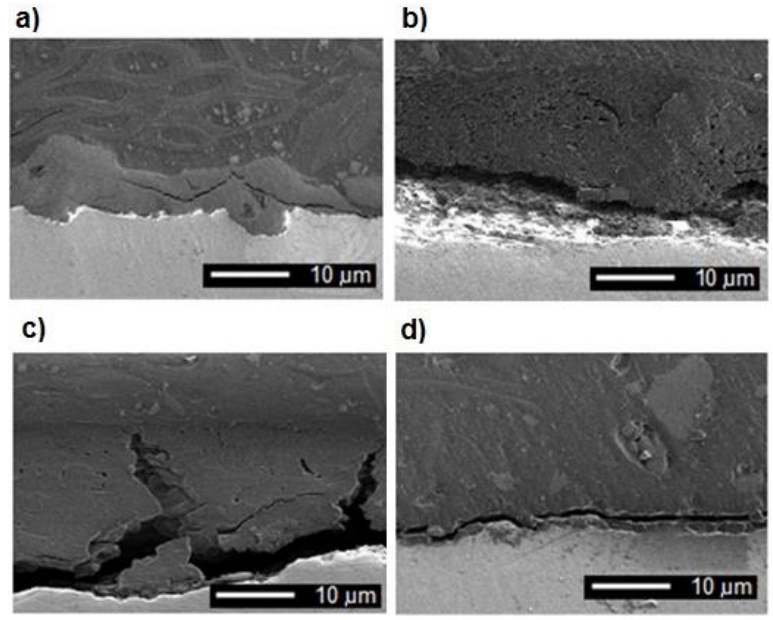
Figure 5. Cross-sections of used dental implants: ( a ) A company; ( b ) B company; ( c ) C company; ( d ) D company. SEM.